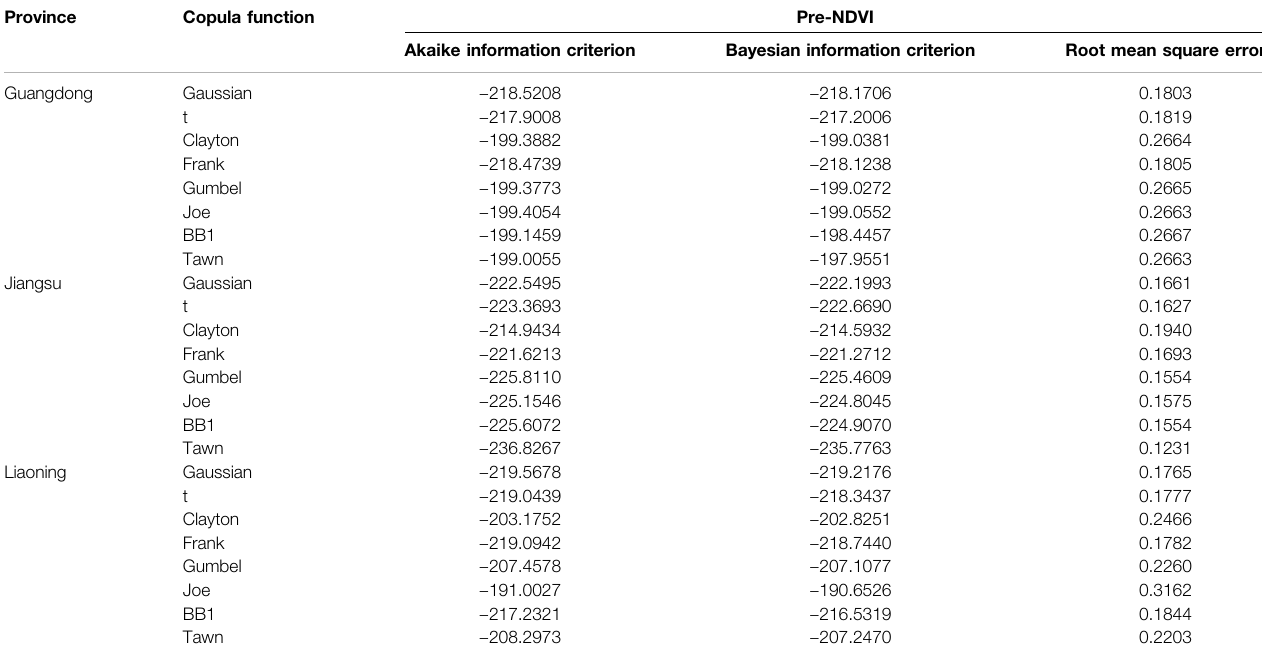
TABLE 4 | Copula function cluster selection criteria for precipitation-normalized difference vegetation index (NDVI) in Guangdong, Jiangsu, and Liaoning.